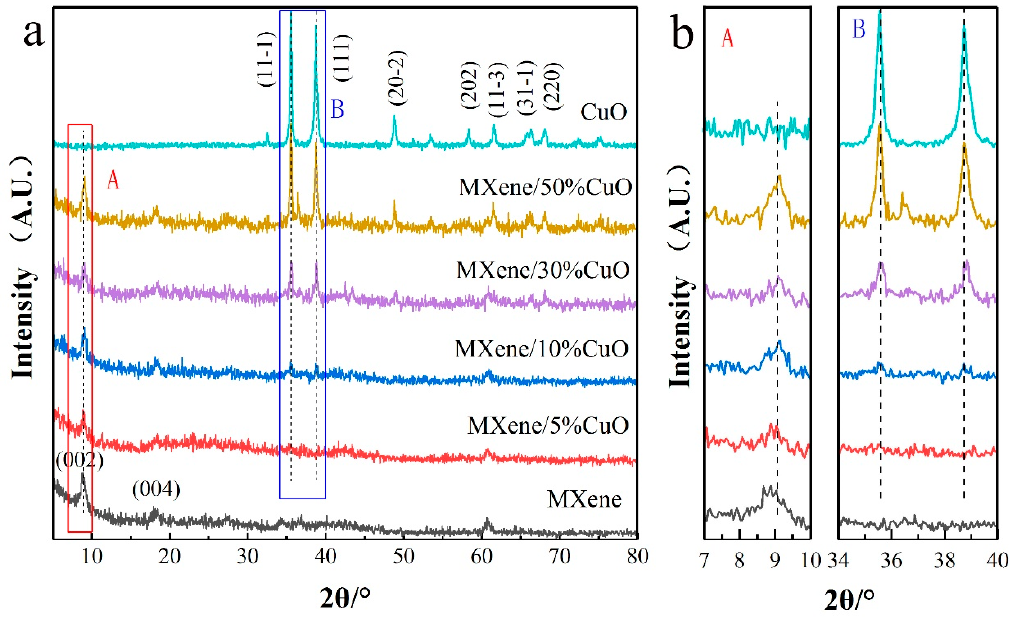
Figure 2. ( a ) X-ray diffraction (XRD) diffraction pattern of MXene, CuO, and MXene/x% CuO (x = 5, 10, 30, and 50); ( b ) Enlarged profiles of the selected area in Figure 2a.